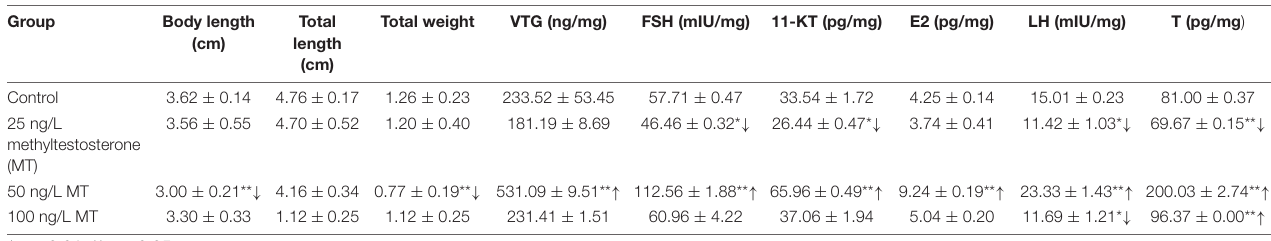
TABLE 1 | Biological indicator and the content of hormones in treatment and control groups.